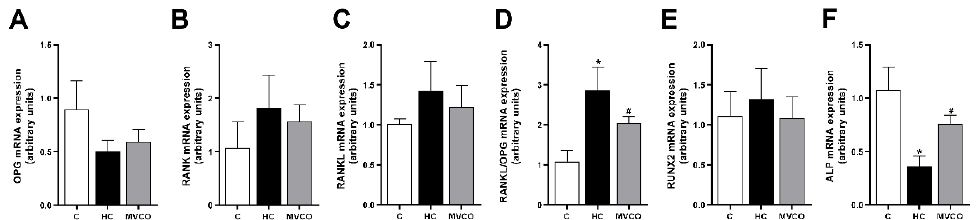
Figure 5. Effect of dietary VCO supplementation in the mRNA expression in the maxilla. ( A ) mRNA expression of Opg, ( B ) receptor activator of nuclear factor κ B (Rank) and ( C ) receptor activator of nuclear factor κ B ligand (Rankl). ( D ) Rankl/Opg ratio. ( E ) Runx2 and ( F ) Alp. Analyses were performed in mice fed a chow diet (C), high refined carbohydrate-containing diet (HC), and HC diet supplemented with 3000 mg/kg body weight of virgin coconut oil (MVCO). Values are means ± SEM ( n = 5). * compared with the control (C) group ( P < 0.05); # compared with HC group ( P < 0.05).